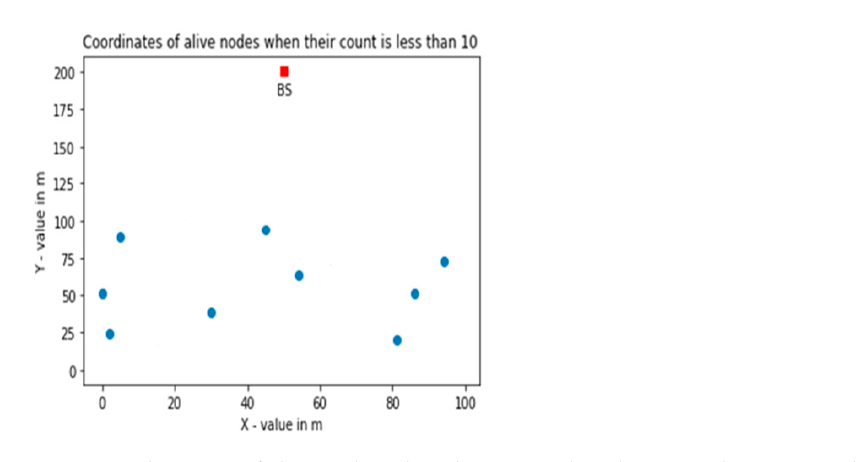
Figure 18. Placement of alive nodes when the count is less than 10 with incremental distribution of high energy nodes.